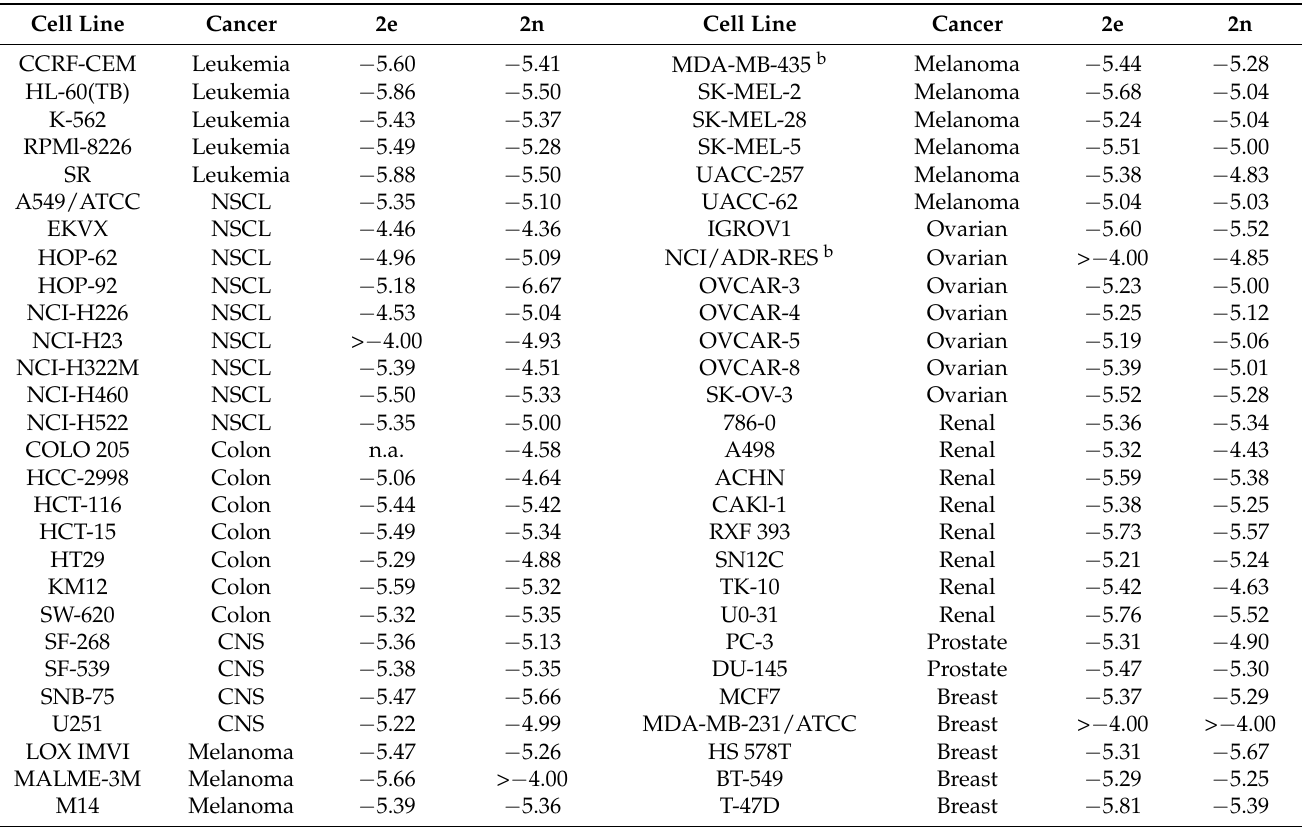
Table 5. In vitro antiproliferative activity of 2e and 2n on cultured cancer cell lines in the cancer cell line screen of the NCI. Data displayed as log 10 GI 50 [M] values a